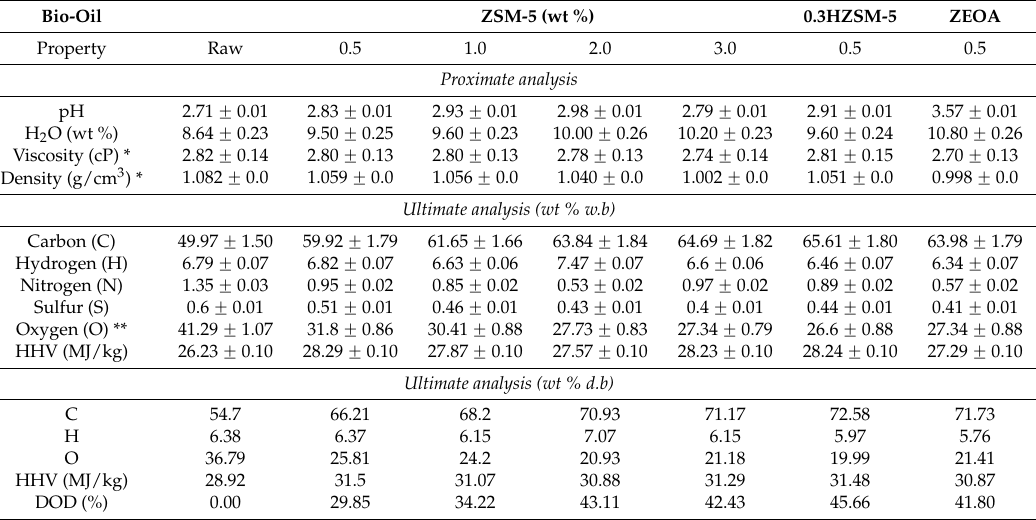
* Measured at 20 ˝ C; ** by difference [O = 100